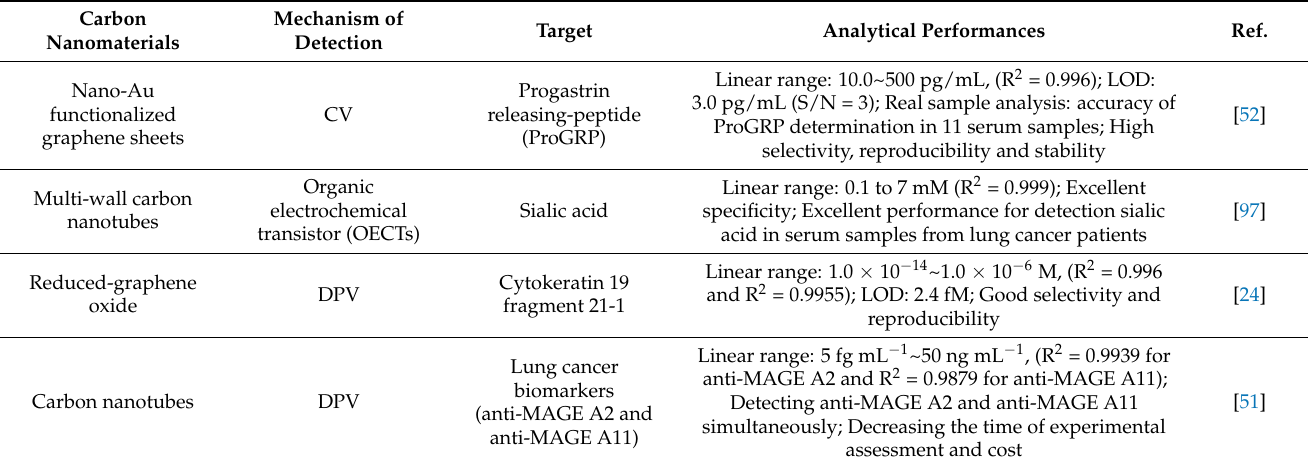
Table 5. Performance of electrochemical biosensors for lung cancer